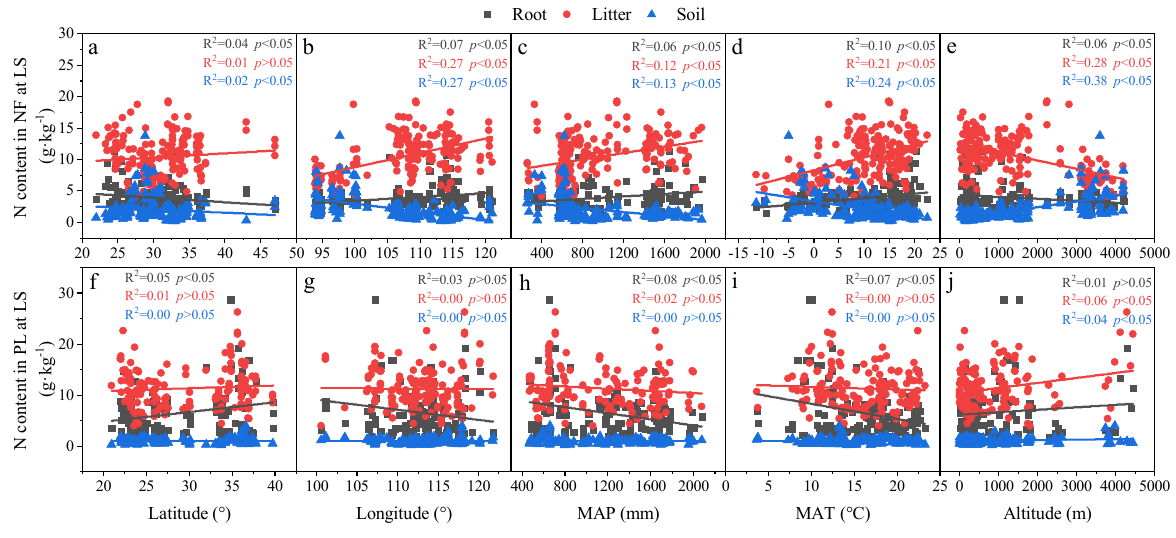
Figure A5. N content changes with latitude ( a , f ), longitude ( b , g ), mean annual precipitation (MAP) ( c , h ), mean annual temperature (MAT) ( d , i ) and altitude ( e , j ) in different forest origins in the middle stage (MS). The number of forest sites are 344 and 199 for NF − MS and PL − MS, respectively.